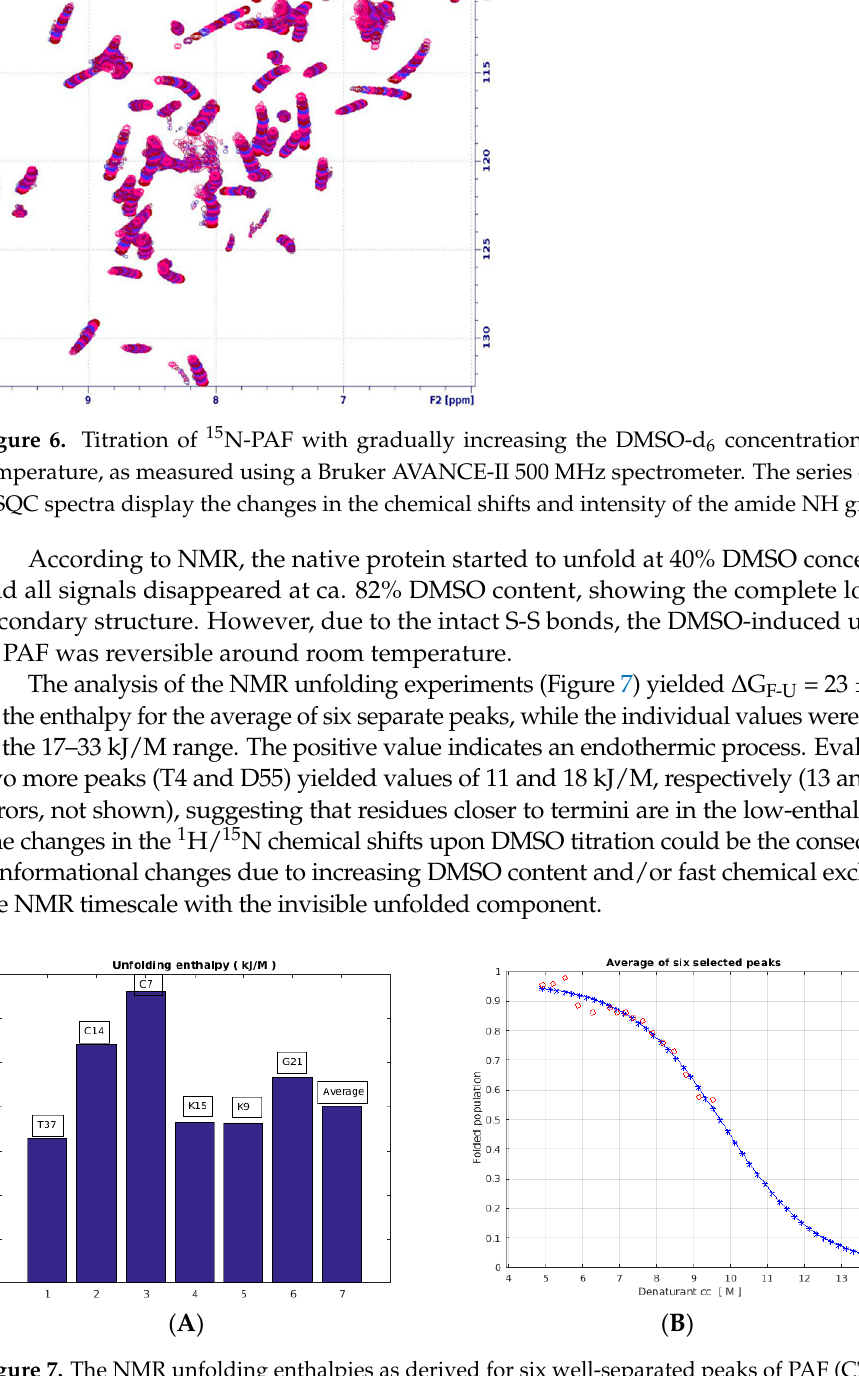
Figure 7. The NMR unfolding enthalpies as derived for six well ‐ separated peaks of PAF (C7, K9, C14, K15, G21, and T37) and for the average ( A ), as obtained from HSQC experiments measured at 310 K temperature. For the average of six peak volumes ( B ), we obtained ∆ G F ‐ U = 20.0 kJ/M, and the fit error was 3.1%, while the individual errors were in the 4–9% range (see also Figure S3).